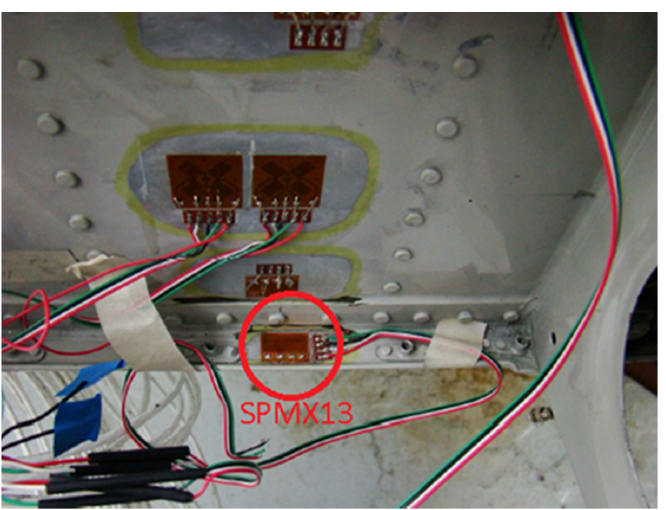
Figure 1. Micromeasurements CEA-250UT 350 Ohm strain gage pattern and technical data.